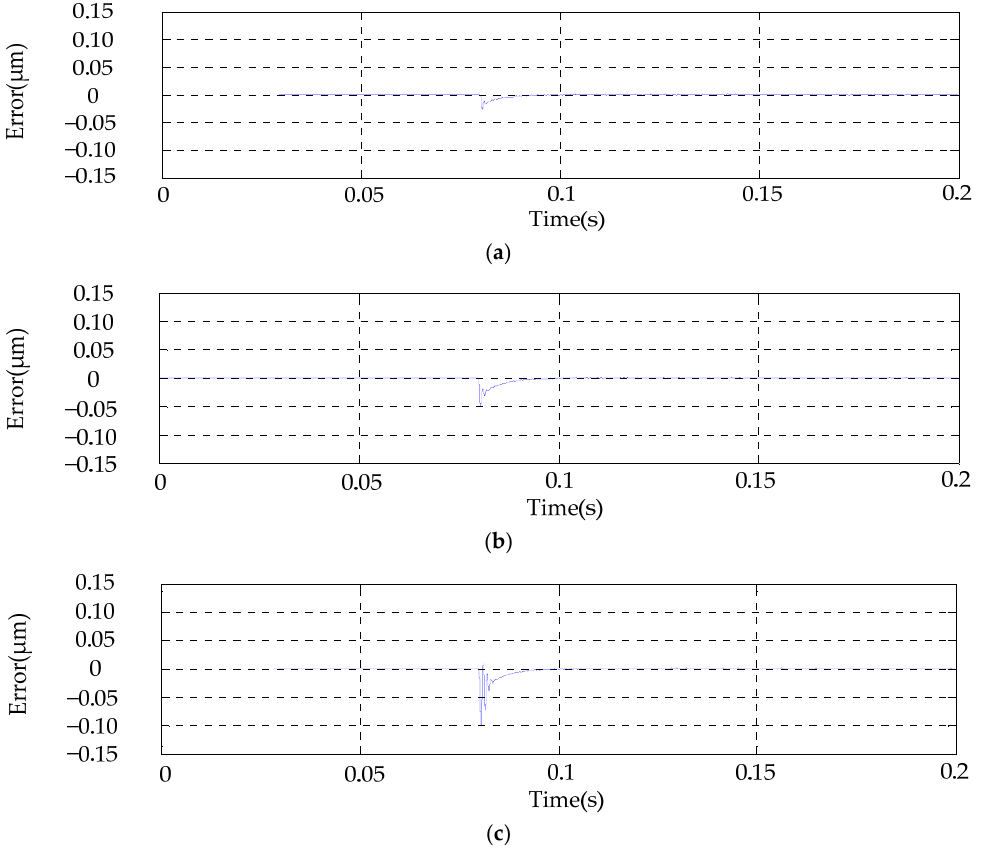
Figure 8. Synchronous deviation between Y 1 and Y 2 : ( a ) disturbance force 20 N; ( b ) disturbance force 35 N; ( c ) disturbance force 50 N.